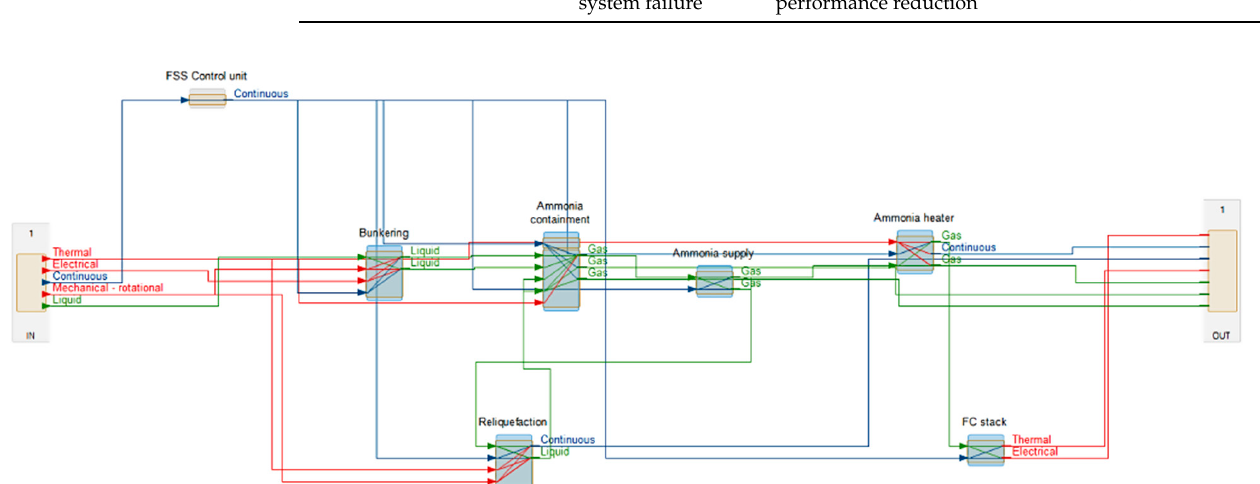
Figure 4. Functional model of the proposed ammonia fuel-cell supply system. The different systems are modelled as blue boxes and the various components are shown with pale brown. As observed, the various items are organised to represent their functional dependencies. Furthermore, the model shows the distinct inputs and outputs within each item. As seen, the inputs and outputs can take several forms including the transfer of data, energy, and material. To that end, outputs from one subsystem or component must be treated as an input for another element. For instance, the gas static pressure that is the output of the NH 3 containment system is used as an input for the NH 3 supply system, together with continuous data provided from the system’s controller. Moreover, it should be clarified that the modelling process is based on engineering knowledge, and the final arrangement of flows and components was validated with the equipment